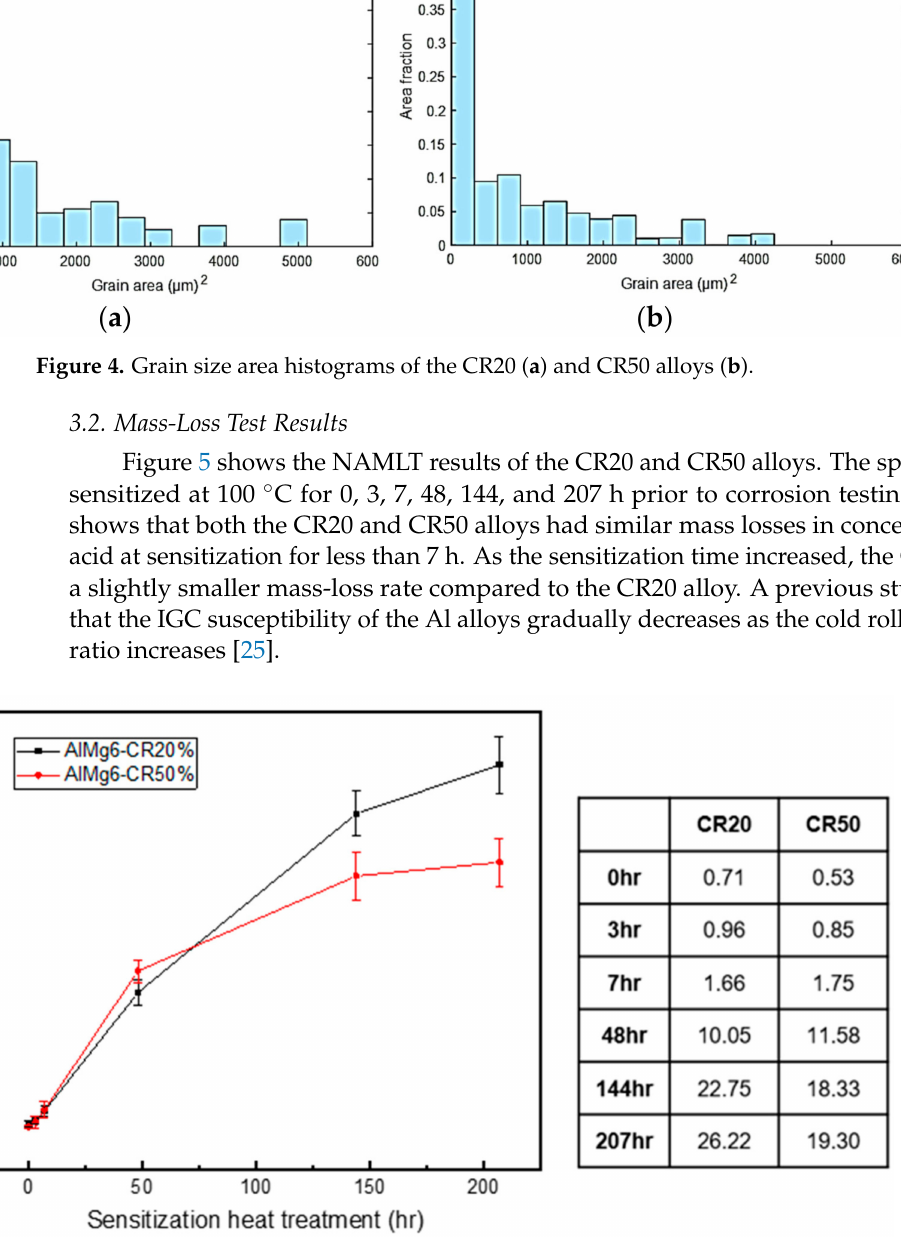
Figure 5. NAMLT results of the CR20 alloy and CR50 alloy with different aging times at 100 ◦